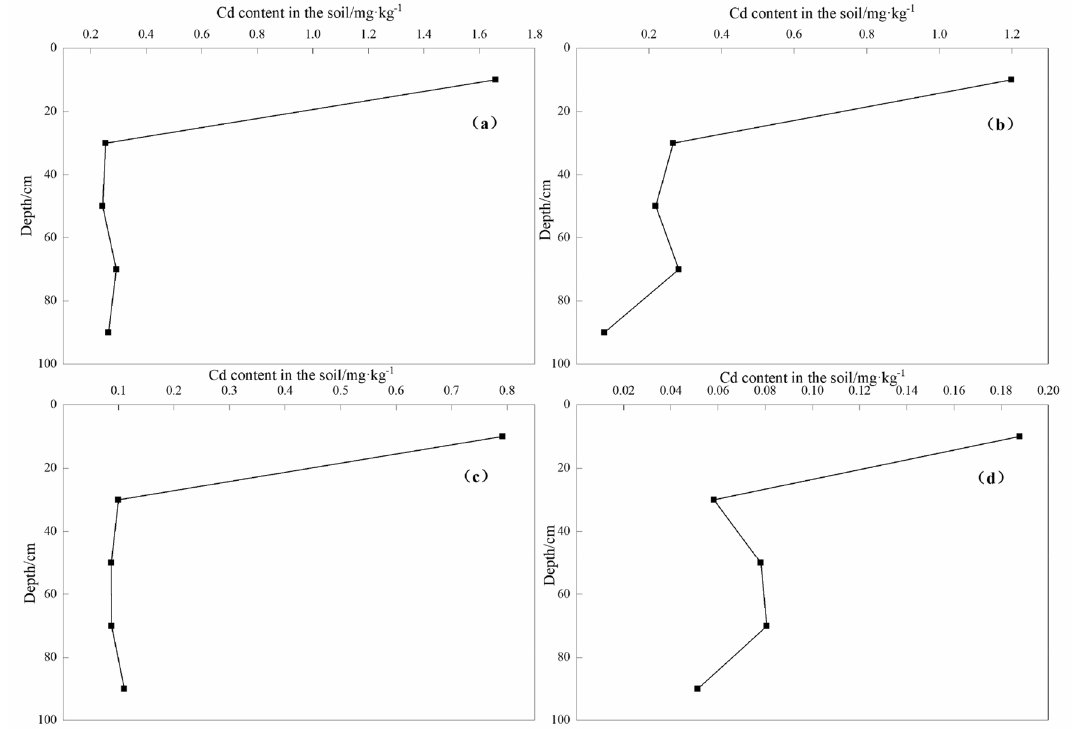
Figure 6. Cd concentrations at different depth in soil profiles. ( a ) D3 soil profile ( b ) D2 soil profile ( c ) D1 soil profile ( d ) D0 soil